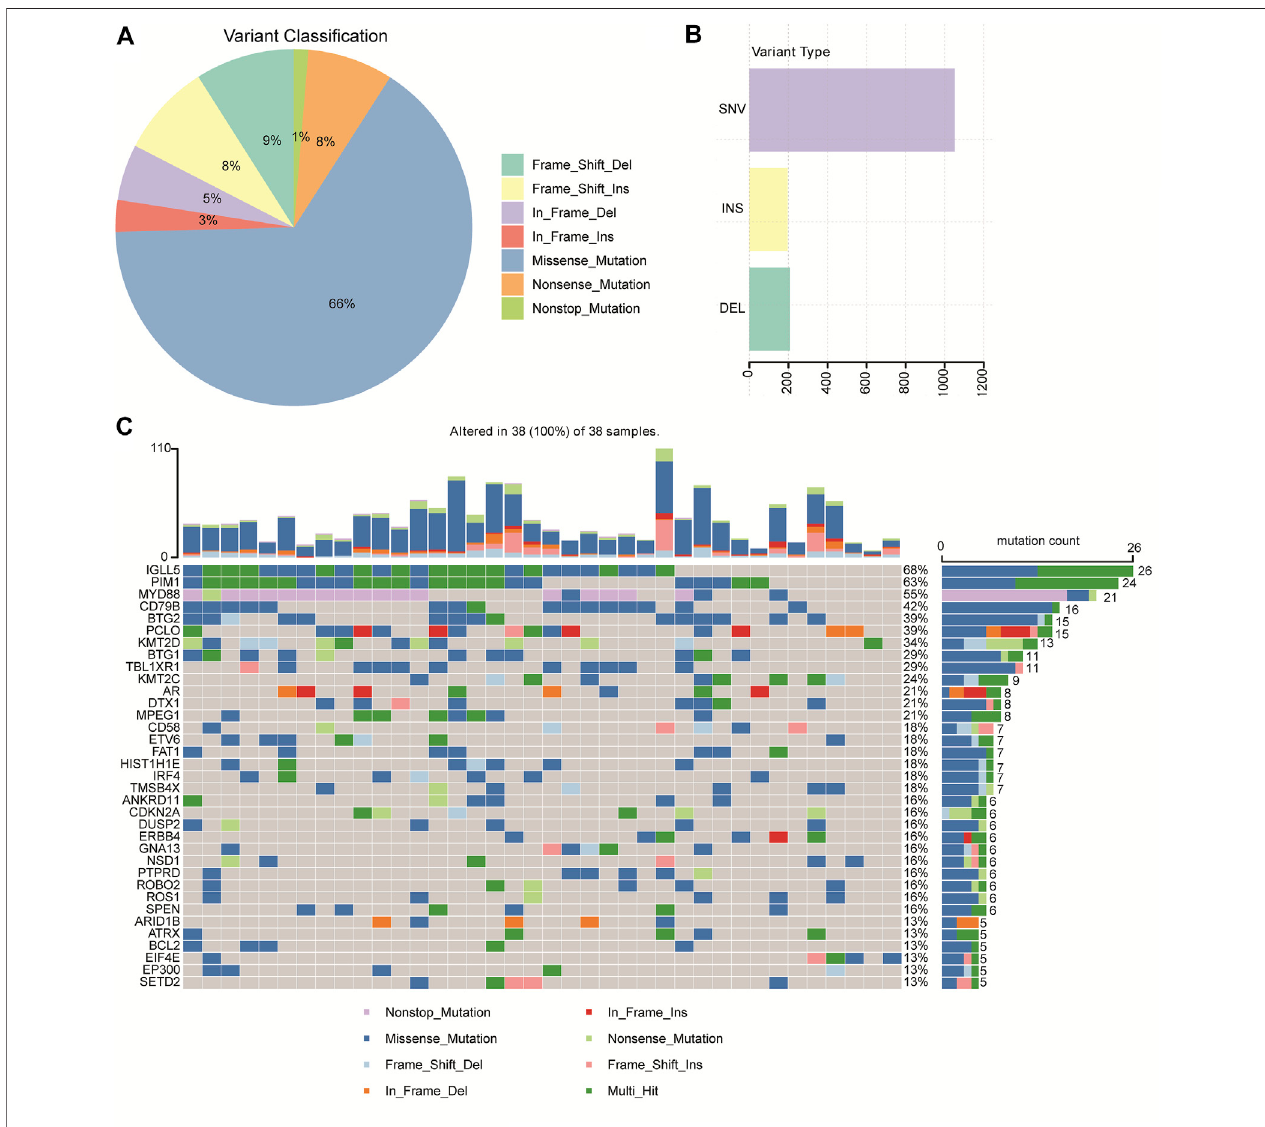
FIGURE1| Mutationpro fi lesidenti fi edbyWGS/WESin38patientswithprimaryCNSDLBCL. (A) Piechartshowingthepercentagesofdifferenttypesofmutation in primary CNS DLBCL. (B) Number of SNV (single nucleotide variation), INS (insert), and DEL (deletion) detected in primary CNS DLBCL. (C) Genes with the most frequent mutations in each patient with primary CNS